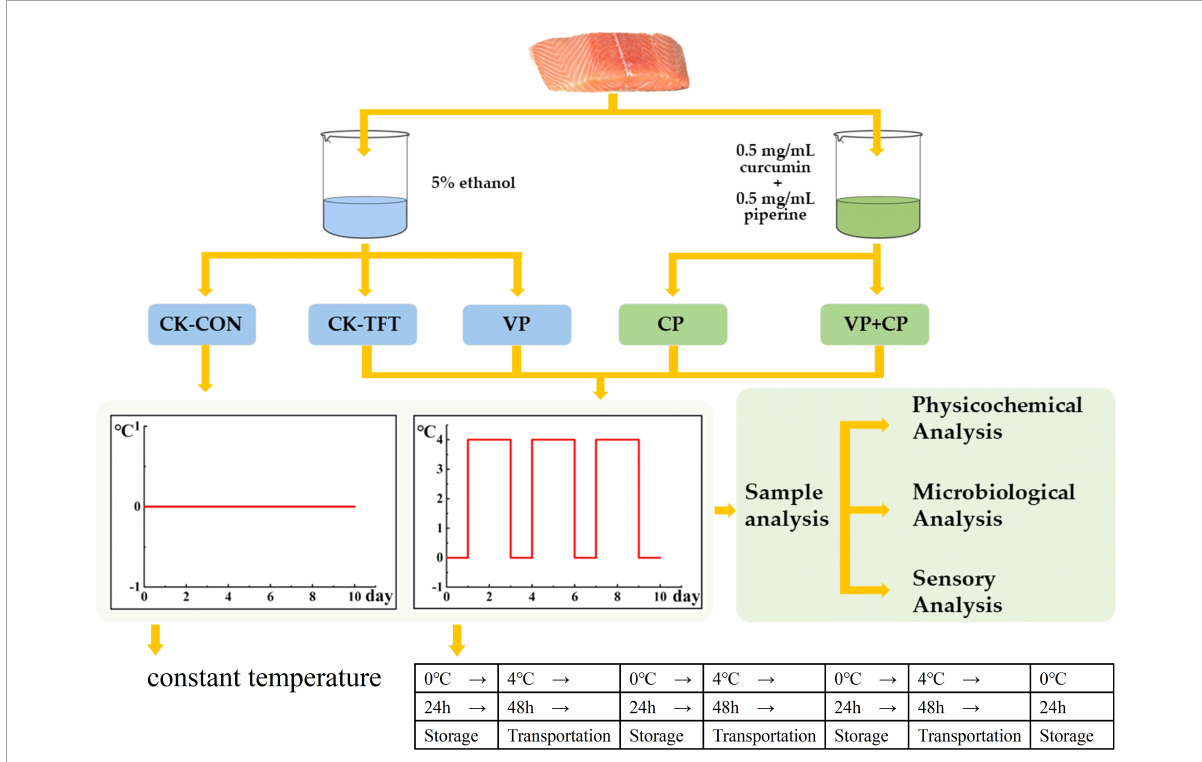
FIGURE1 A schematic overview of the designation and process of this